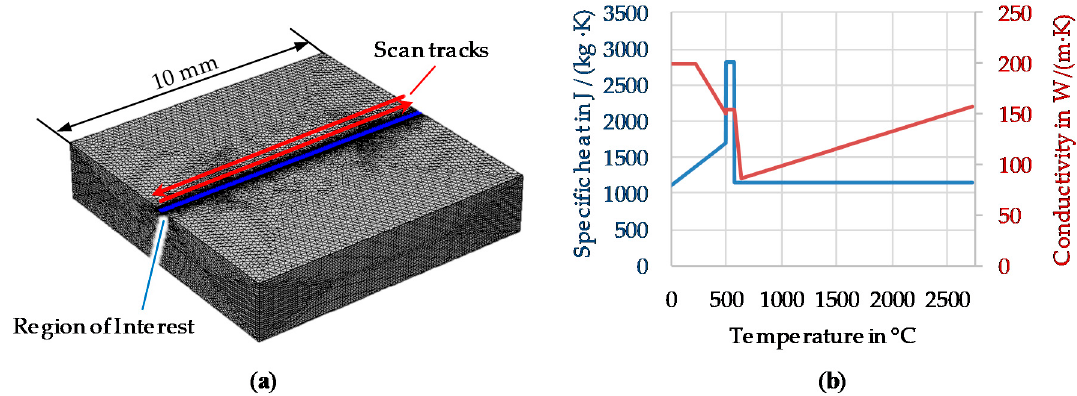
Figure 7. ( a ) Meshed geometry for the simulative setup ( b ) Specific heat capacity and thermal conductivity calculated with JMatPro 10.4 and smoothed.